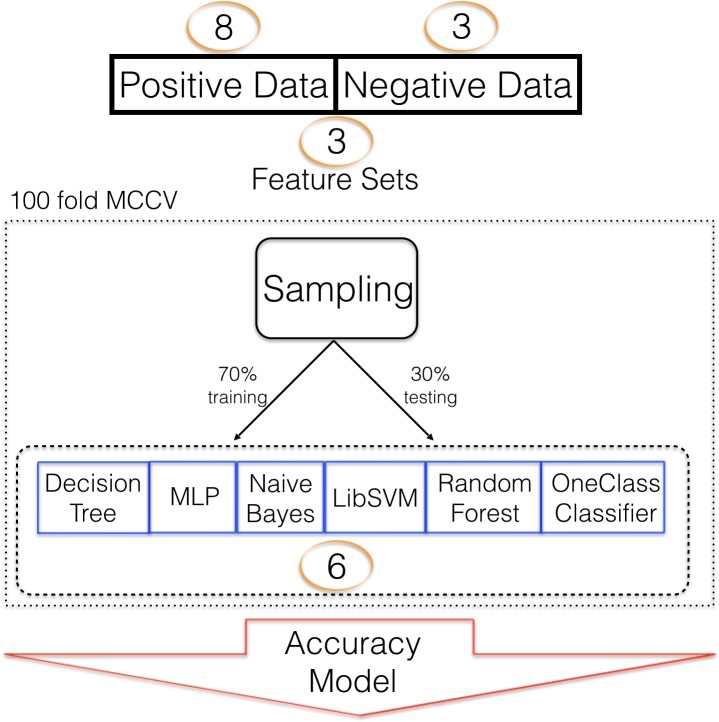
Machine learning strategy.Machine learning strategy employed to establish models describing pre-miRNAs for mouse. Number of alternative sets are written in circles e.g., 3 different feature sets were used.